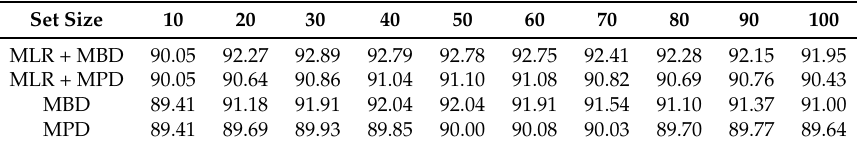
Table 14. Set size discussion for set-based dissimilarity on